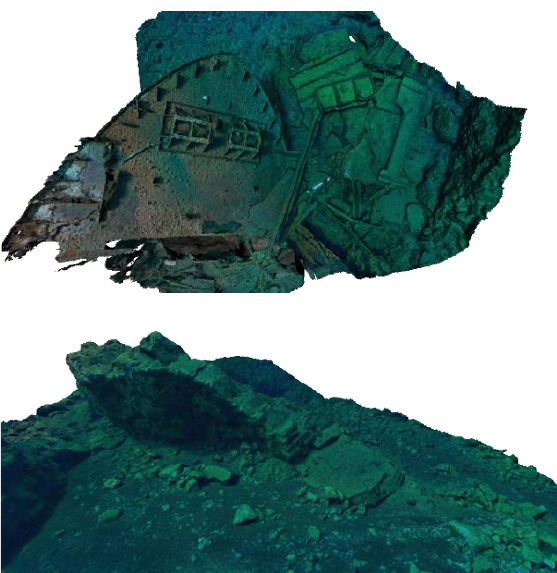
Figure 8. Top-3D model of the shipwreck, Bottom-3D model of Dykes), Santorini